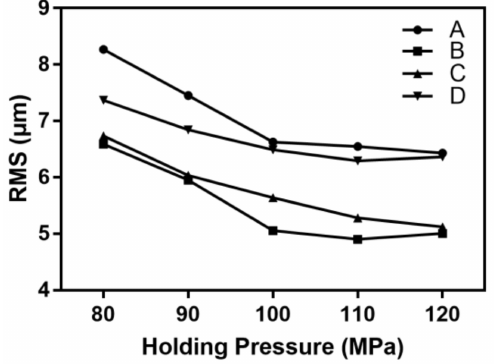
Figure 9. The influence of holding pressure on the RMS of the microchannel.